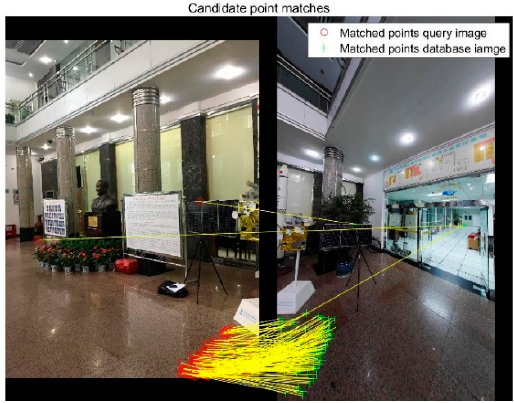
Figure 8. Bad match image with 182 matches after geometry check.